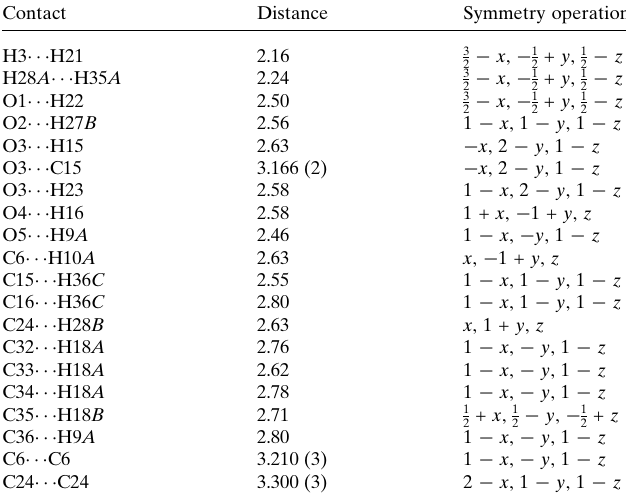
Table 2 Summary of short interatomic contacts (A˚ ) in